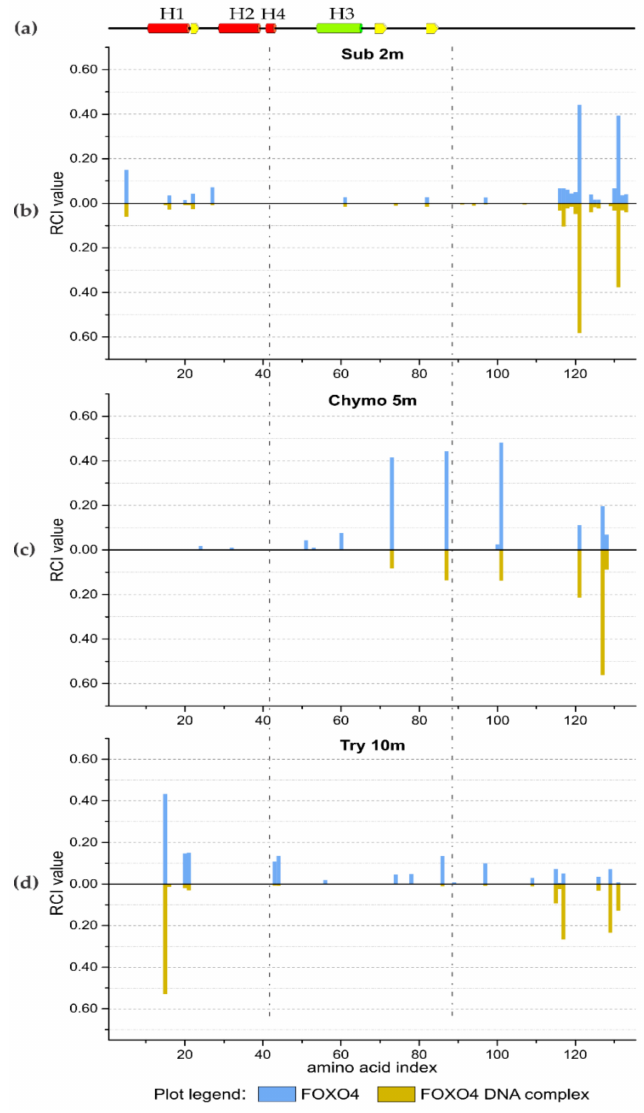
Figure 3. The secondary structure motifs of FOXO4 ( a ) are displayed at the top; dash-dotted lines cover the region Lys 45–Phe 87 which remains resistant to proteolysis in the presence of DNA. Relative Amino Acid Cleavage Incidence (RCI) value butterfly plots of FOXO4 and FOXO4 / DAF16 DNA complex at di ff erent time points: 2 min for subtilisin A ( b ), 5 min for α -chymotrypsin ( c ), and 10 min for trypsin ( d ) where major di ff erences were